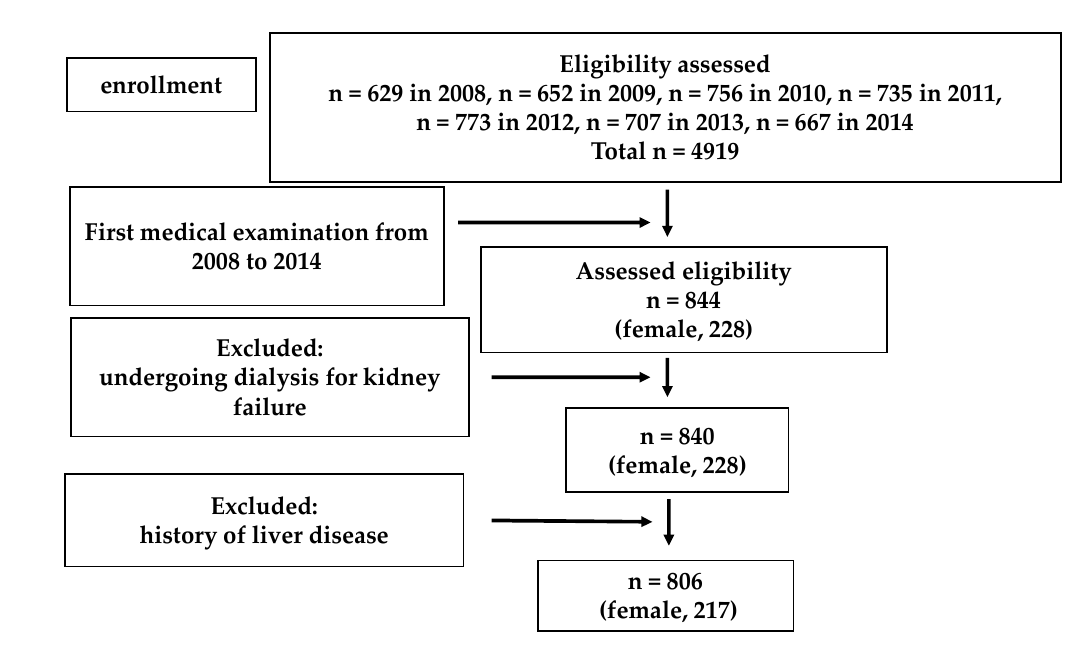
Figure 1. Flow chart of the Study 1 population selection.